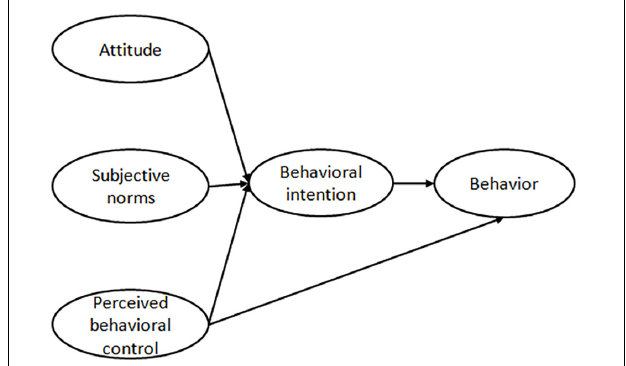
FIGURE 1 | The framework of the Theory of Planned Behavior proposed by Icek